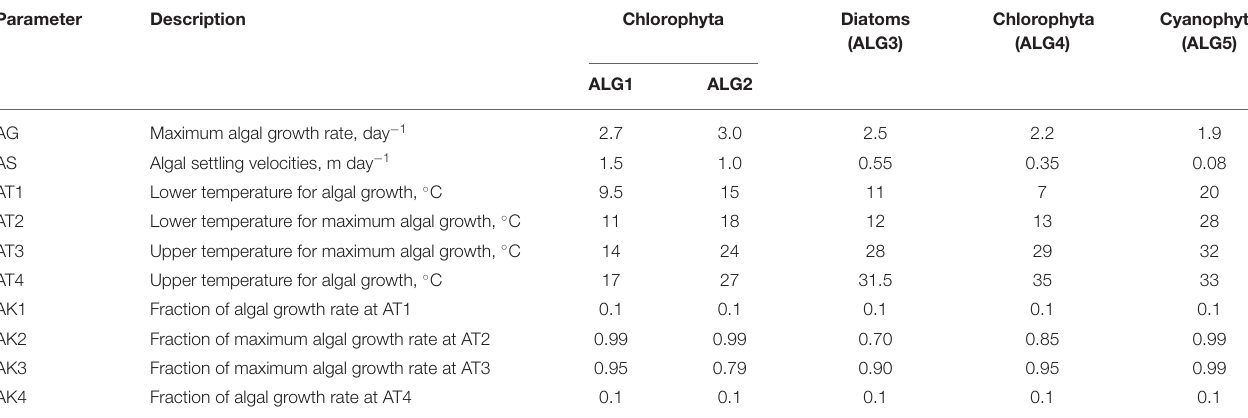
TABLE 2 | The main control parameters of algal model in the Xiangxi